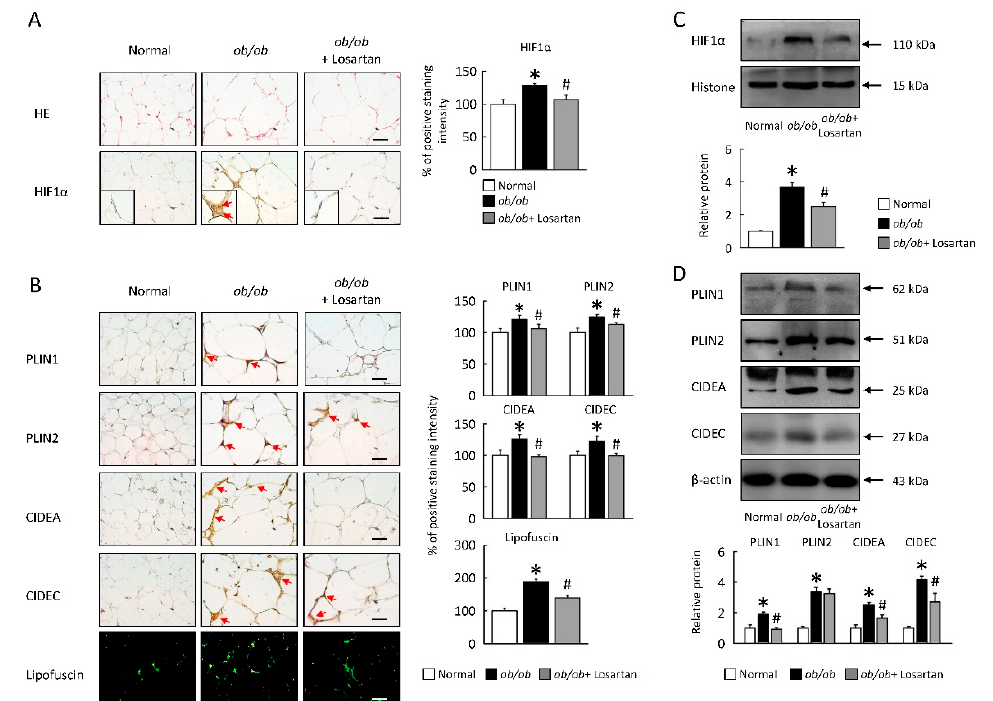
Figure 3. Losartan attenuated HIF1 α expression and LDs formation in EWAT. ( A ) Representative HE and HIF1 α staining. Red arrow highlights the positive staining. Scale bar: 100 µ m. Tissue staining, as quantified by either stain intensity, is represented on the left-hand vertical axis in each graph. ( B ) Representative PLIN1, PLIN2, CIDEA, and CIDEC staining of EWAT. Green pseudocolor represents visualization of lipofuscin’s autofluorescence at 450–490 nm. Red arrow highlights the positive staining. Scale bar: 100 µ m. Tissue staining, as quantified by either stain intensity, is represented on the left-hand vertical axis in each graph. Quantification of ( C ) HIF1 α protein levels by Western blot. Below graph indicate quantification relative to Histone. Quantification of ( D ) PLIN1, PLIN2, CIDEA, and CIDEC protein levels by Western blot of EWAT. Below graphs indicate quantification relative to β -actin. For each animal group, n = 5. All values represent the mean ± SEM. Data were analyzed by Student’s t test. * p ≤ 0.05, normal vs. ob/ob ; # p ≤ 0.05, ob/ob vs. ob/ob + Losartan. HIF1 α : hypoxia-inducible factor 1 α ; LDs: lipid droplets; EWAT: epididymal white adipose tissue; HE: hematoxylin and eosin stain; PLIN1: perilipin 1; CIDEA: cell death inducing DFFA like effector